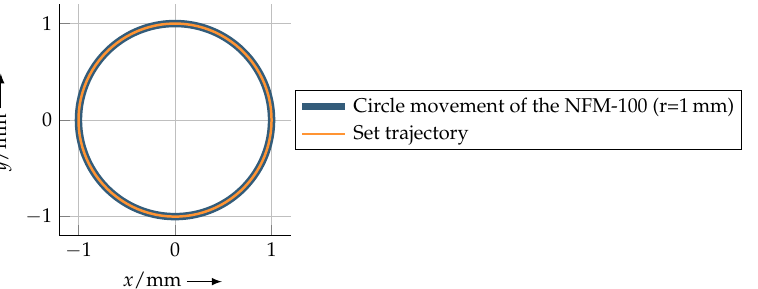
Figure 10. Positioning accuracy of a circle movement by the NFM-100 with a radius of 1mm and a circumferential velocity of 10 mm/s. Here, the standard deviation of the radius is 3.107 nm (1 σ ). The angular ϕ Z deviation in this case is